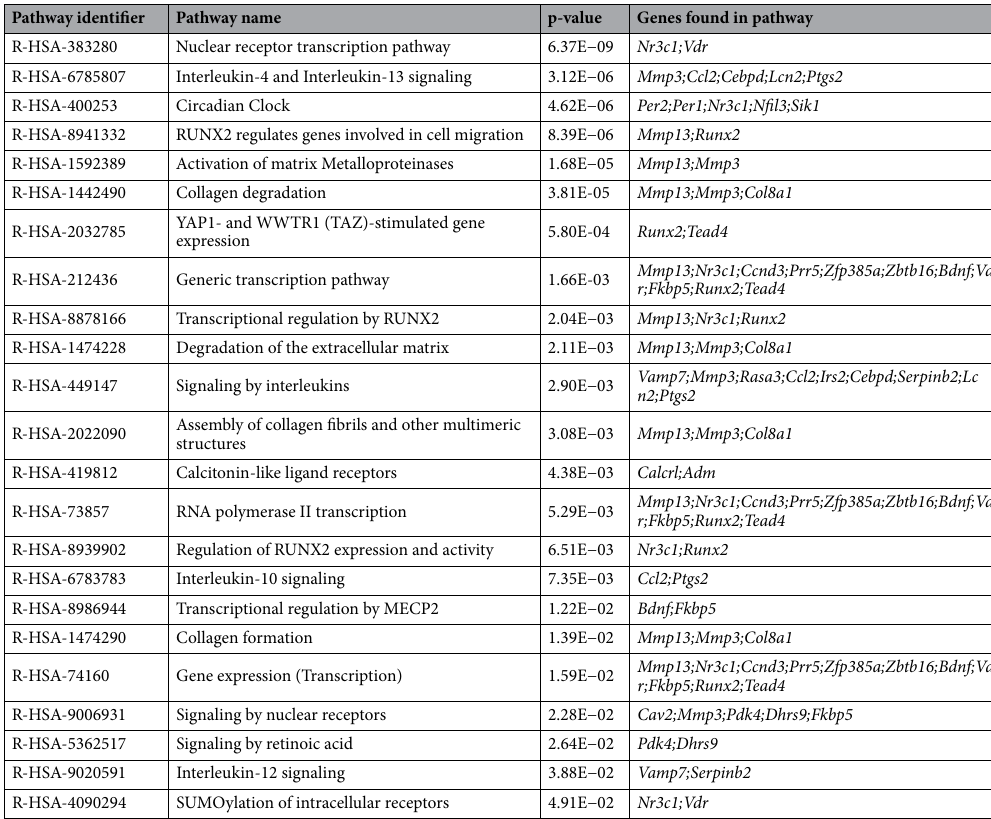
Table 2. Reactome pathway analysis of genes changed by MCH in ciliated 3T3-L1